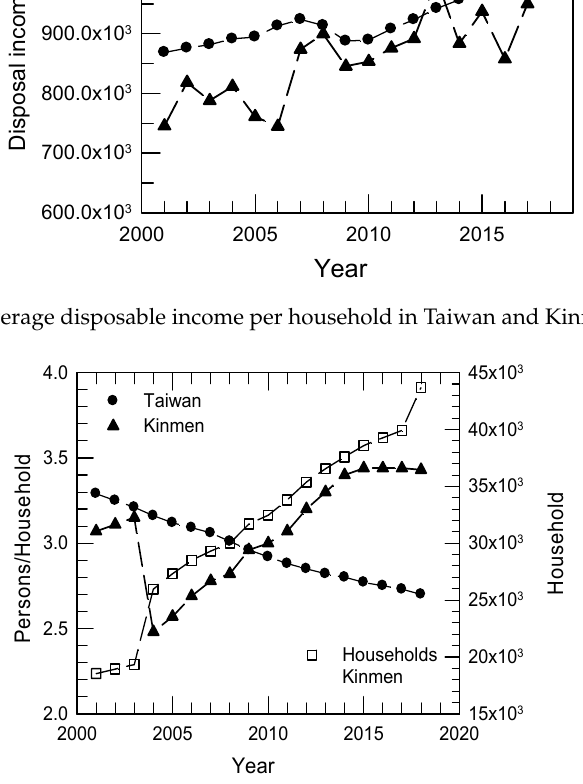
Figure 6. Household structure for SWH users in Taiwan and Kinmen County.